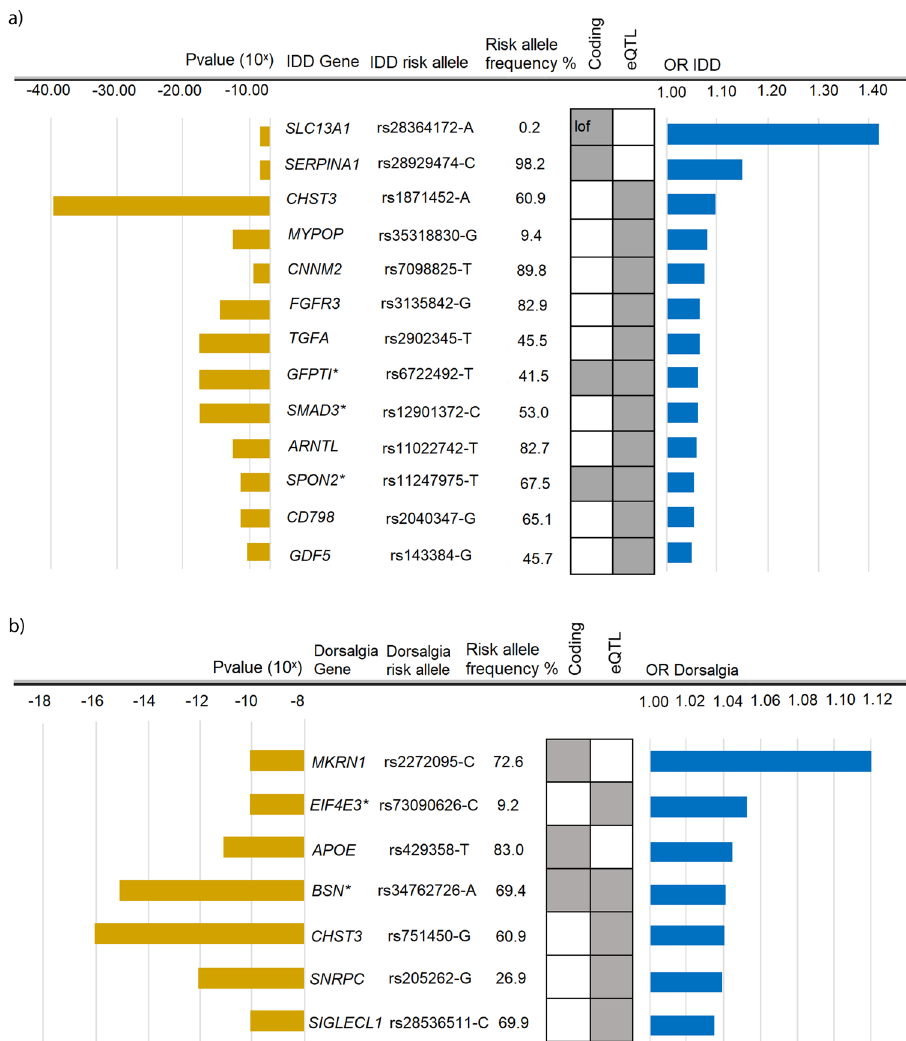
Fig. 2 Genes likely to associate with (a) IDD and (b) Dorsalgia. Sequence variants associated with ( a ) IDD and ( b ) Dorsalgia for which functional evidence supports implication of genes in back pain. The variants listed are either protein-coding variants or affect mRNA expression (top cis-eQTL) as depicted by gray boxes (lof loss-of-function) (Supplementary Data 5 – 8). *Variants also associated in cis with mRNA of other genes (Supplementary Data 7, 8). The meta-analyses were performed using logistic regression, the risk (odds ratio OR in yellow) of ( a ) IDD and ( b ) Dorsalgia are here shown for the risk-increasing allele and signi fi cance in blue. COL11A1 and GSDMC are not included in the fi gure as evidence for their association with back pain was derived differently as described in results.